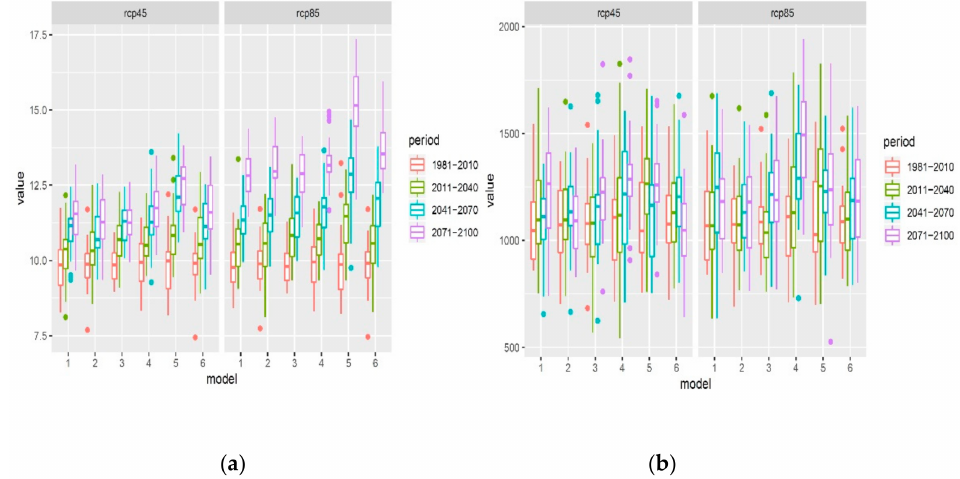
Figure 5. Climate models: ( a ) average temperature ( ◦ C), BC deviation from 1981–2010 related to RCP 4.5 and RCP 8.5, six characteristic climate models and periods; ( b ) average precipitation (mm), BC deviation from 1981–2010 related to RCP 4.5 and RCP 8.5, and six characteristic climate models and